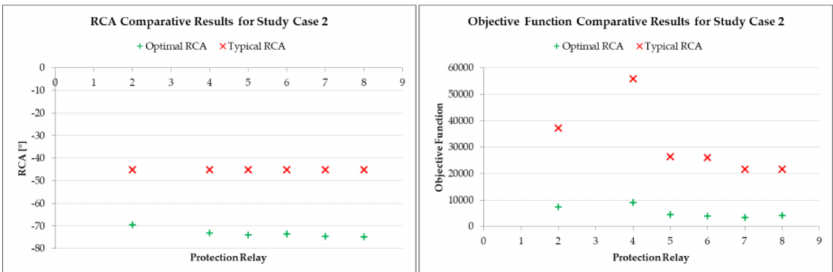
Figure 14. Comparative results for the evaluation of polarization on the directional ground overcurrent element (ANSI 67N) in the protection relays of Study Case 2—negative sequence polarization.